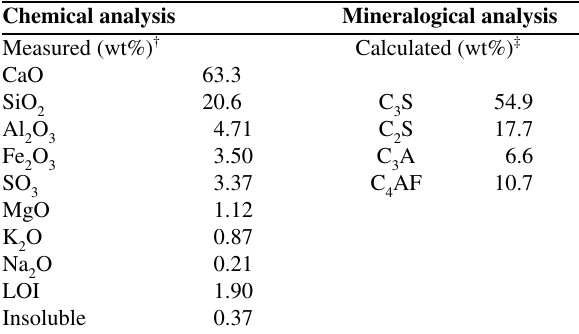
Table 1. Chemical and mineralogical analysis of CEM I 52.2 R. Chemical